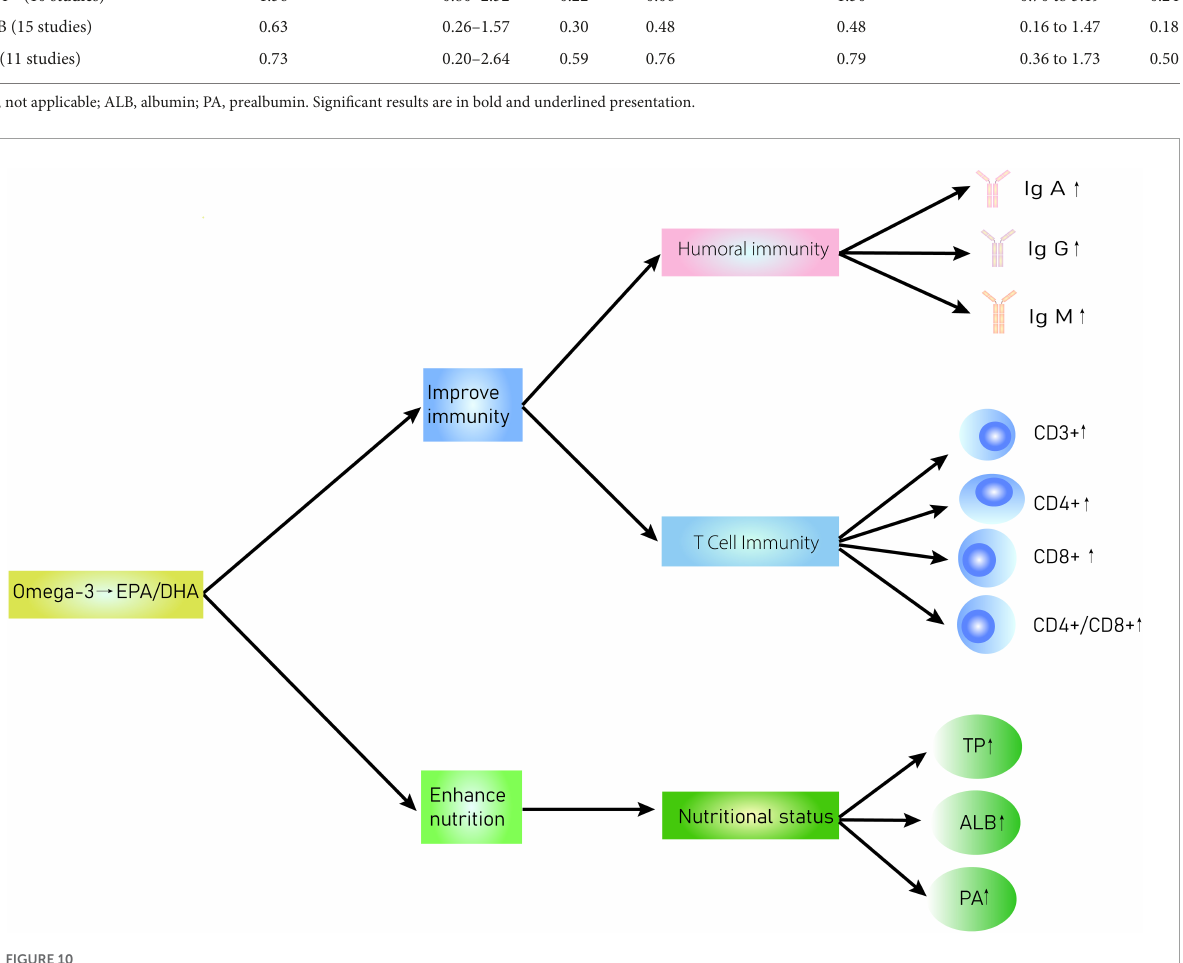
ligands, signal transduction function of cell membranes, and ultimately disrupt the production and release of cytokines, such as inhibiting the degradation of NF- κ B and COX-2 and release of inflammatory factors (60). (3) Deficiency of omega-3 PUFAs